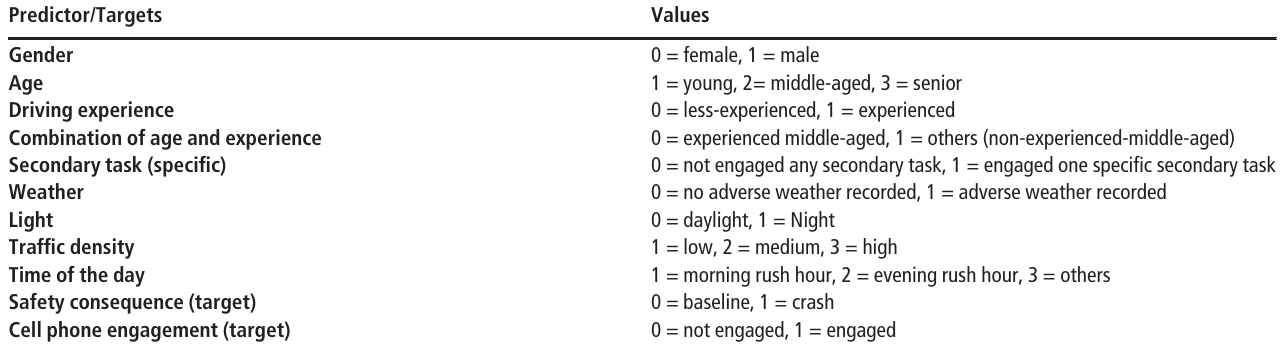
Table AI Predictors and targets by level in regression models Predictor/Targets